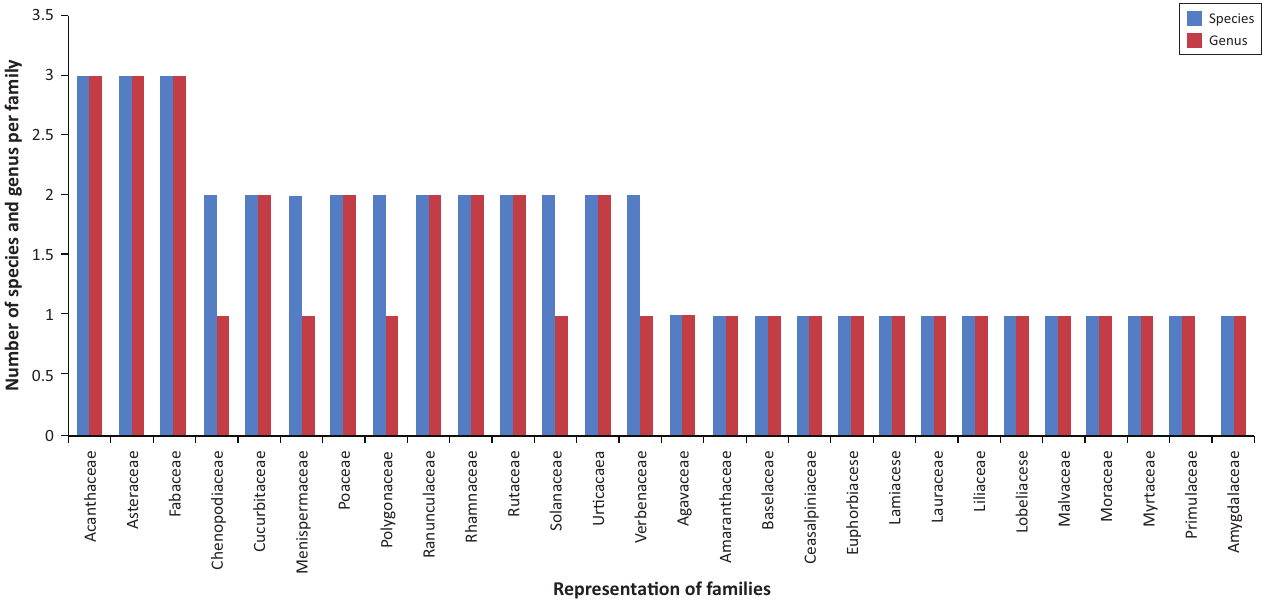
Representa(cid:10)on of families